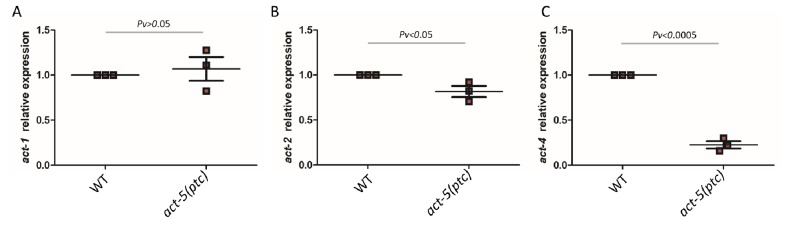
mRNA levels of act-1 (A), act-2 (B) and act-4 (C) in WT and act-5(ptc) mutants.WT expression levels are set at 1. Data are mean ± S.E.M.; average dCt values are shown in Figure 1—source data 2. Two-tailed Student’s t-test was used to calculate P values.